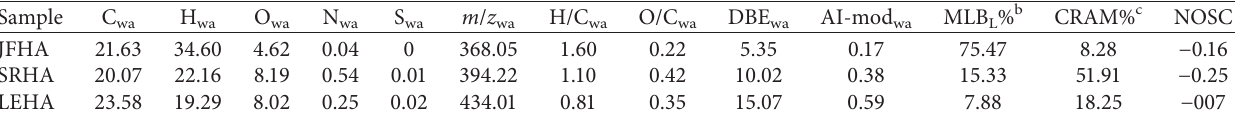
Table 1: Molecular parameters of (a) humic acids from Jiufeng forest soil, (b) humic acids from Suwannee River, and (c) humic acids from leonardite derived from assigned molecular formulas a .